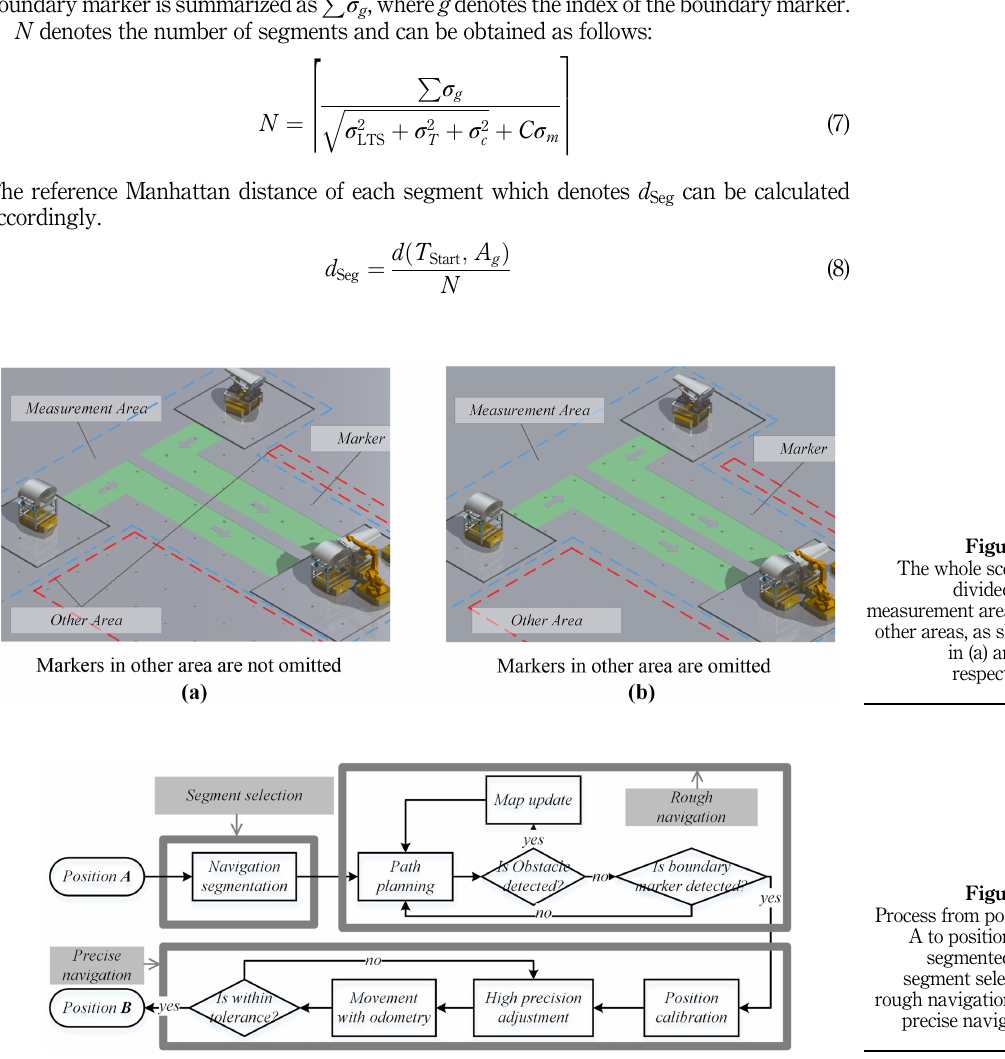
Figure 5. Process from